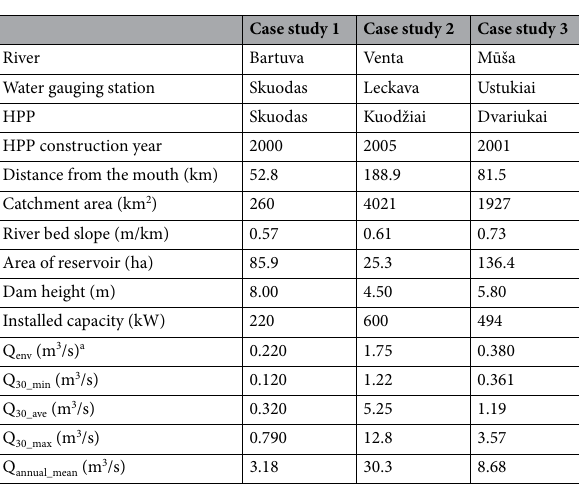
Table 1. Characteristics of the selected case studies at the particular hydropower plant (HPP). a Environmental flow (Q 80% for Bartuva and Q 95% for Venta and Mūša) is derived from the rules of exploitation of HPP